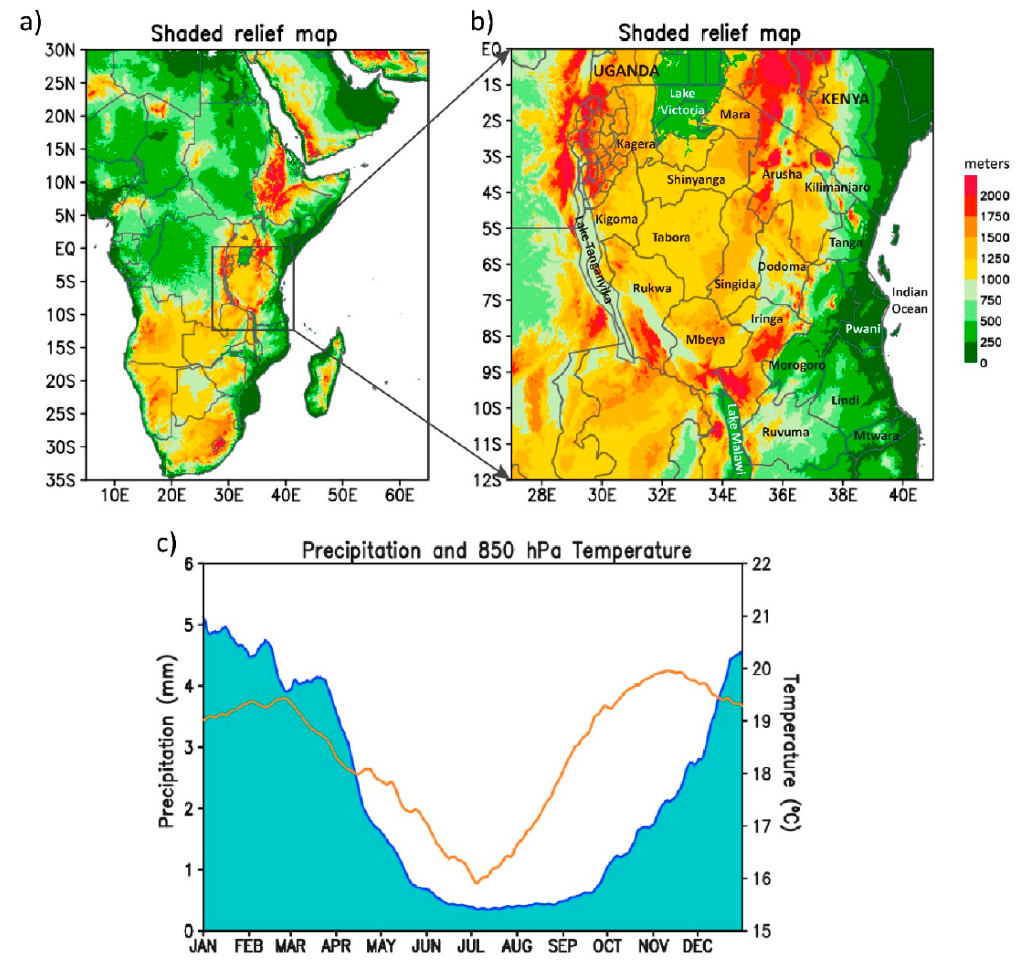
Figure 1. Shaded relief (m) maps of ( a ) Africa and ( b ) Tanzania from ETOPO1. ( c ) 10-day running mean (1981–2010) precipitation (mm) for Tanzania (0–15S, 30–40E) (shaded in blue), and 850-hPa temperature ( ◦ C, orange curve). The 850-hPa temperature data are taken from the Reanalysis 1 (R1) data archive.